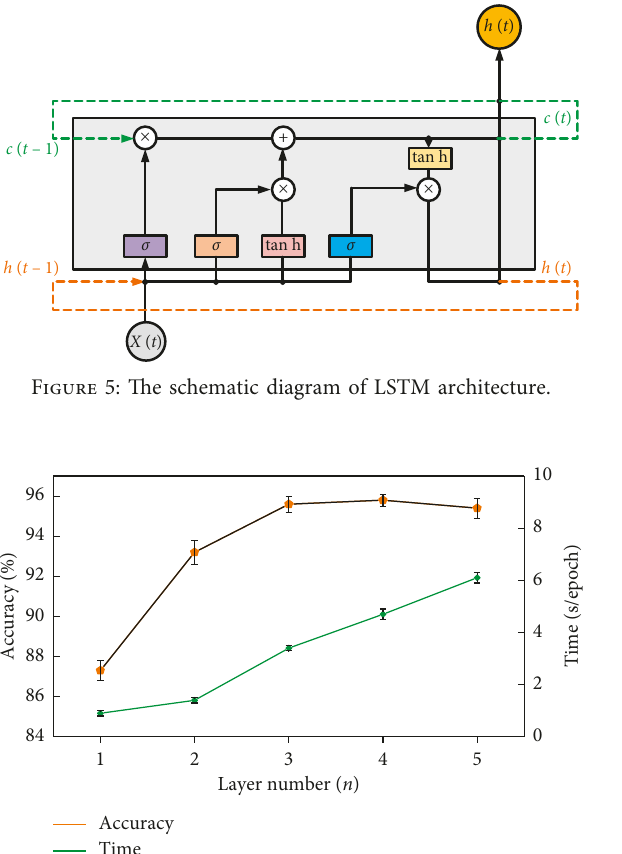
Figure 6: Accuracy and cost time at different layer numbers. The accuracy curve has a distinct rise at the first 3 layers and then tends to be stable, while the cost time always increases as the layers get